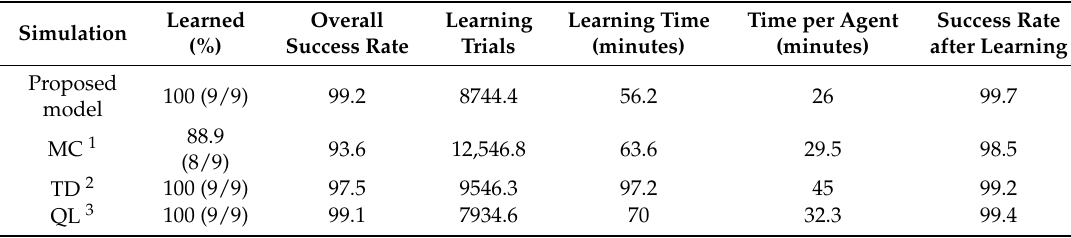
Table 7. Comparison of overall results of state-of-the-art approaches with the proposed model.